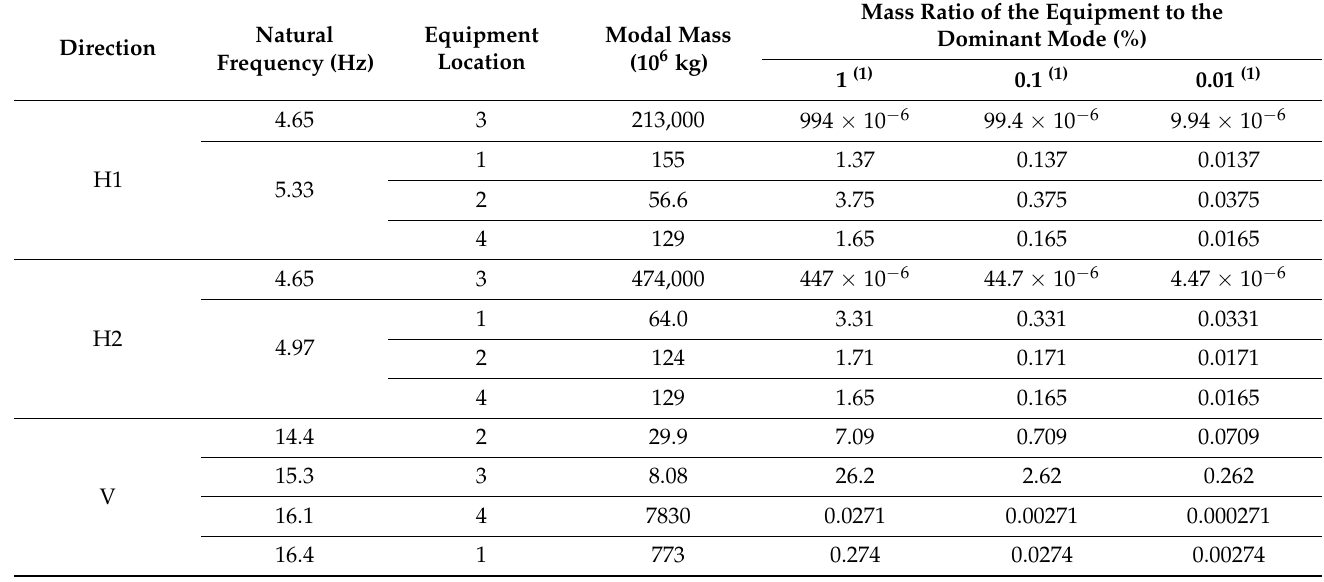
Table 4. Mass ratio of the equipment to the dominant mode for different equipment locations and